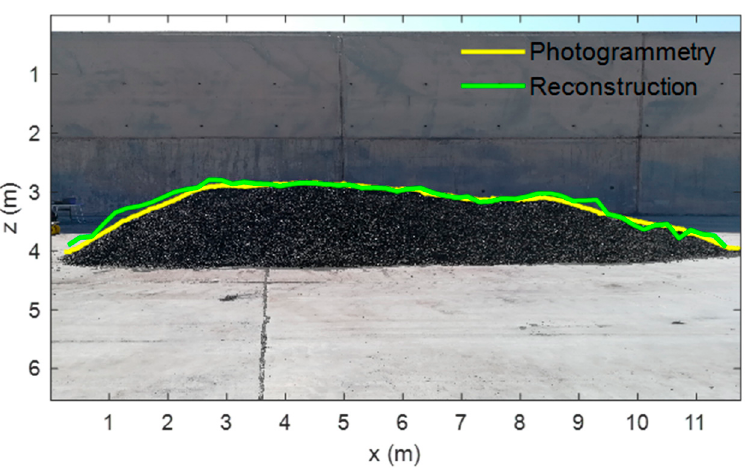
Figure 13. Picture of the stockpile, with the profile being recovered using a photogrammetry-like technique shown in yellow and the profile obtained from the reconstruction in green.